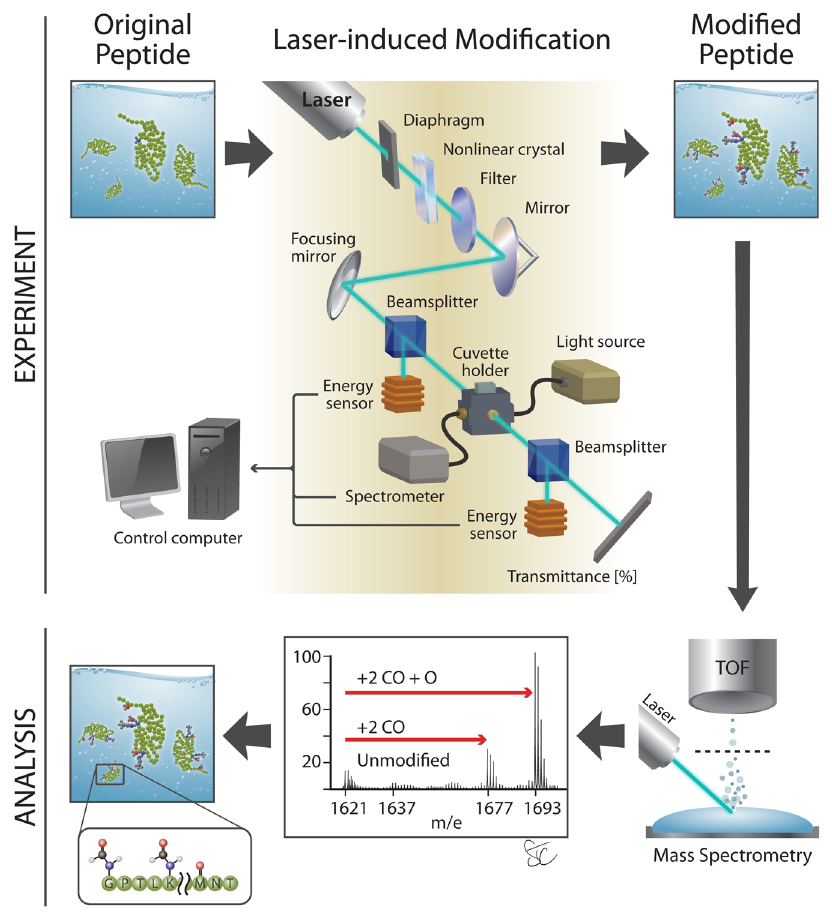
Figure 1. Experimental workflow for laser-induced modification of peptides and proteins in a liquid. Pulses generated by femtosecond laser were frequency-doubled in nonlinear crystal and forwarded to a quartz cuvette to modify liquid samples. The modifications were then detected by on-site optical transmittance spectroscopy. Peptide or protein molecules of the modified samples were analyzed by high-resolution mass spectrometry for detailed characterization of the modifications. Illustrated by Stacy Turpin Cheavens, MS, CMI © Copyright 2016 by The Curators of the University of Missouri, a public